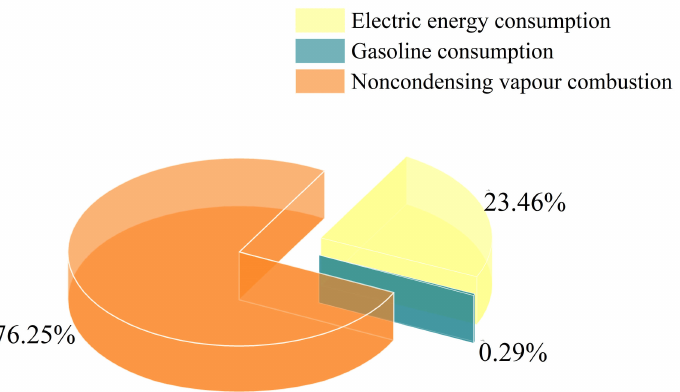
Figure 7. Distribution of CO 2 equivalent emission in each link of the non-phase-transition drying pyrolysis and mass conversion technology.